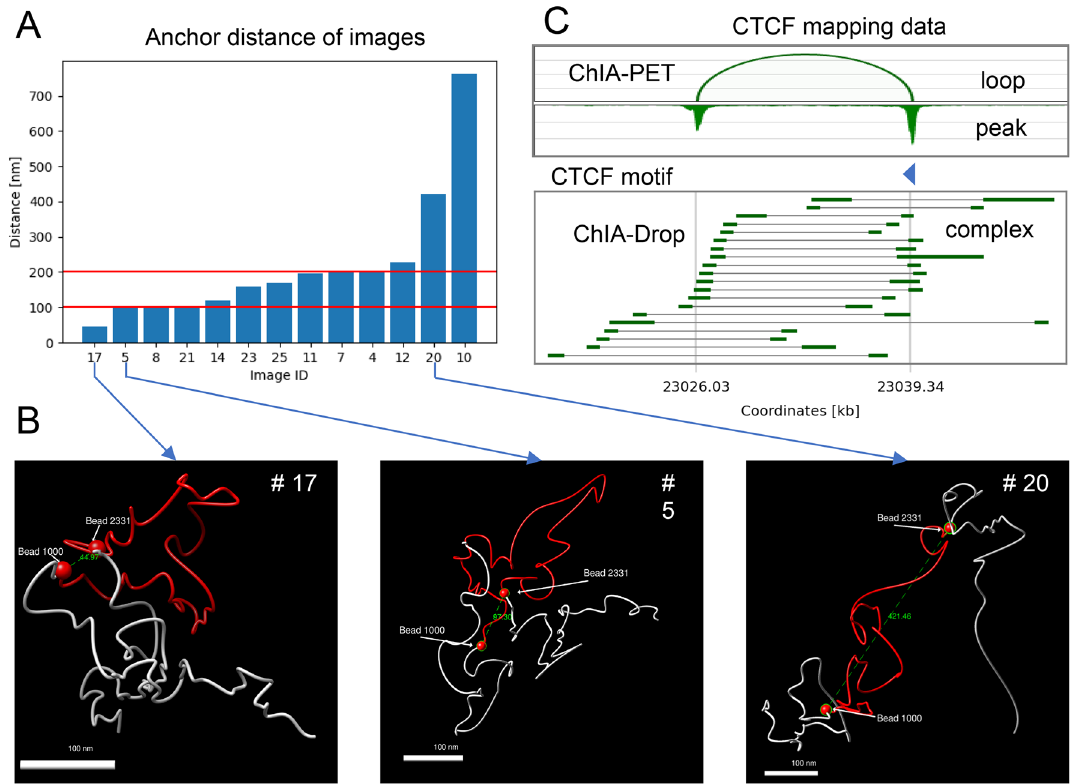
Figure 4. Distribution of loop anchor distances from imaging data-driven polymer model and genomic mapping data. ( A ) Distances between loop anchors from imaging models ( B ) Examples of image models. The loop region is colored in red (chr14:23,026,000–23,039,000). The flanking regions are in grey (chr14:23,016,000– 23,026,000, chr14:23,039,000–23,049,000). In each image, the anchors (chr14:23,026,030 and chr14:23,039,340) were marked by red spheres and the distances (in nanometers) are shown in green. ( C ) CTCF ChIA-PET 18 and ChIA-Drop data (https:// data. 4dnuc leome. org/ exper iment- set- repli cates/ 4DNES X18HS 2V/) at the target loop region. 20 CTCF ChIA-Drop complexes represent the heterogeneity of loop structure in single